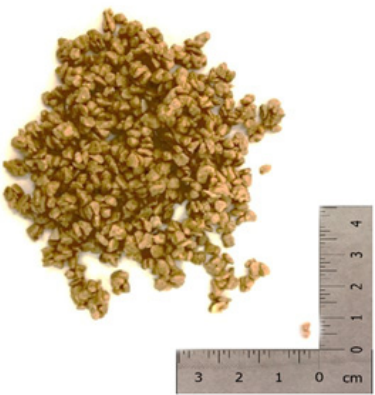
Figure 2. Form–stable LS / PEG composite obtained through the vacuum impregnation process.